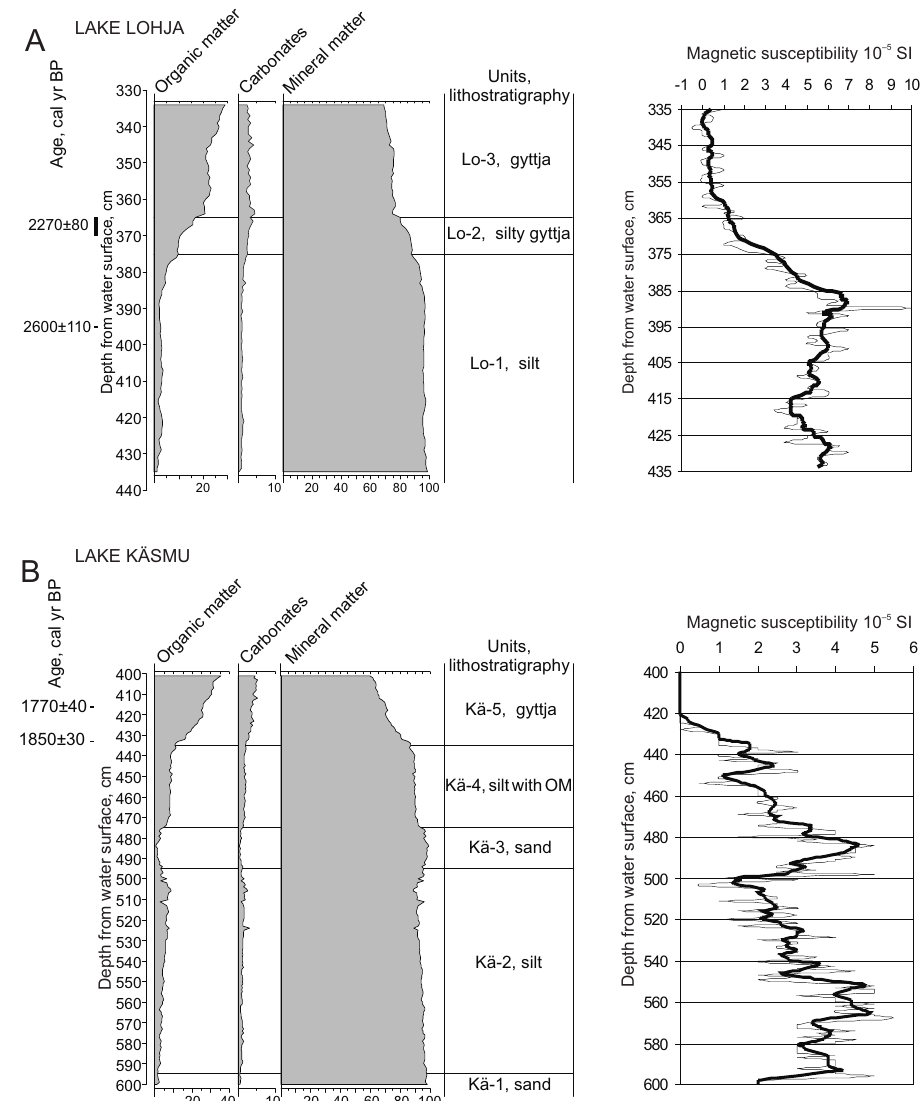
Fig. 2. Loss-on-ignition and magnetic susceptibility of Lake Lohja (A) and Lake K(cid:228)smu (B). The thick black line in the magnetic susceptibility graph is 5-sample moving